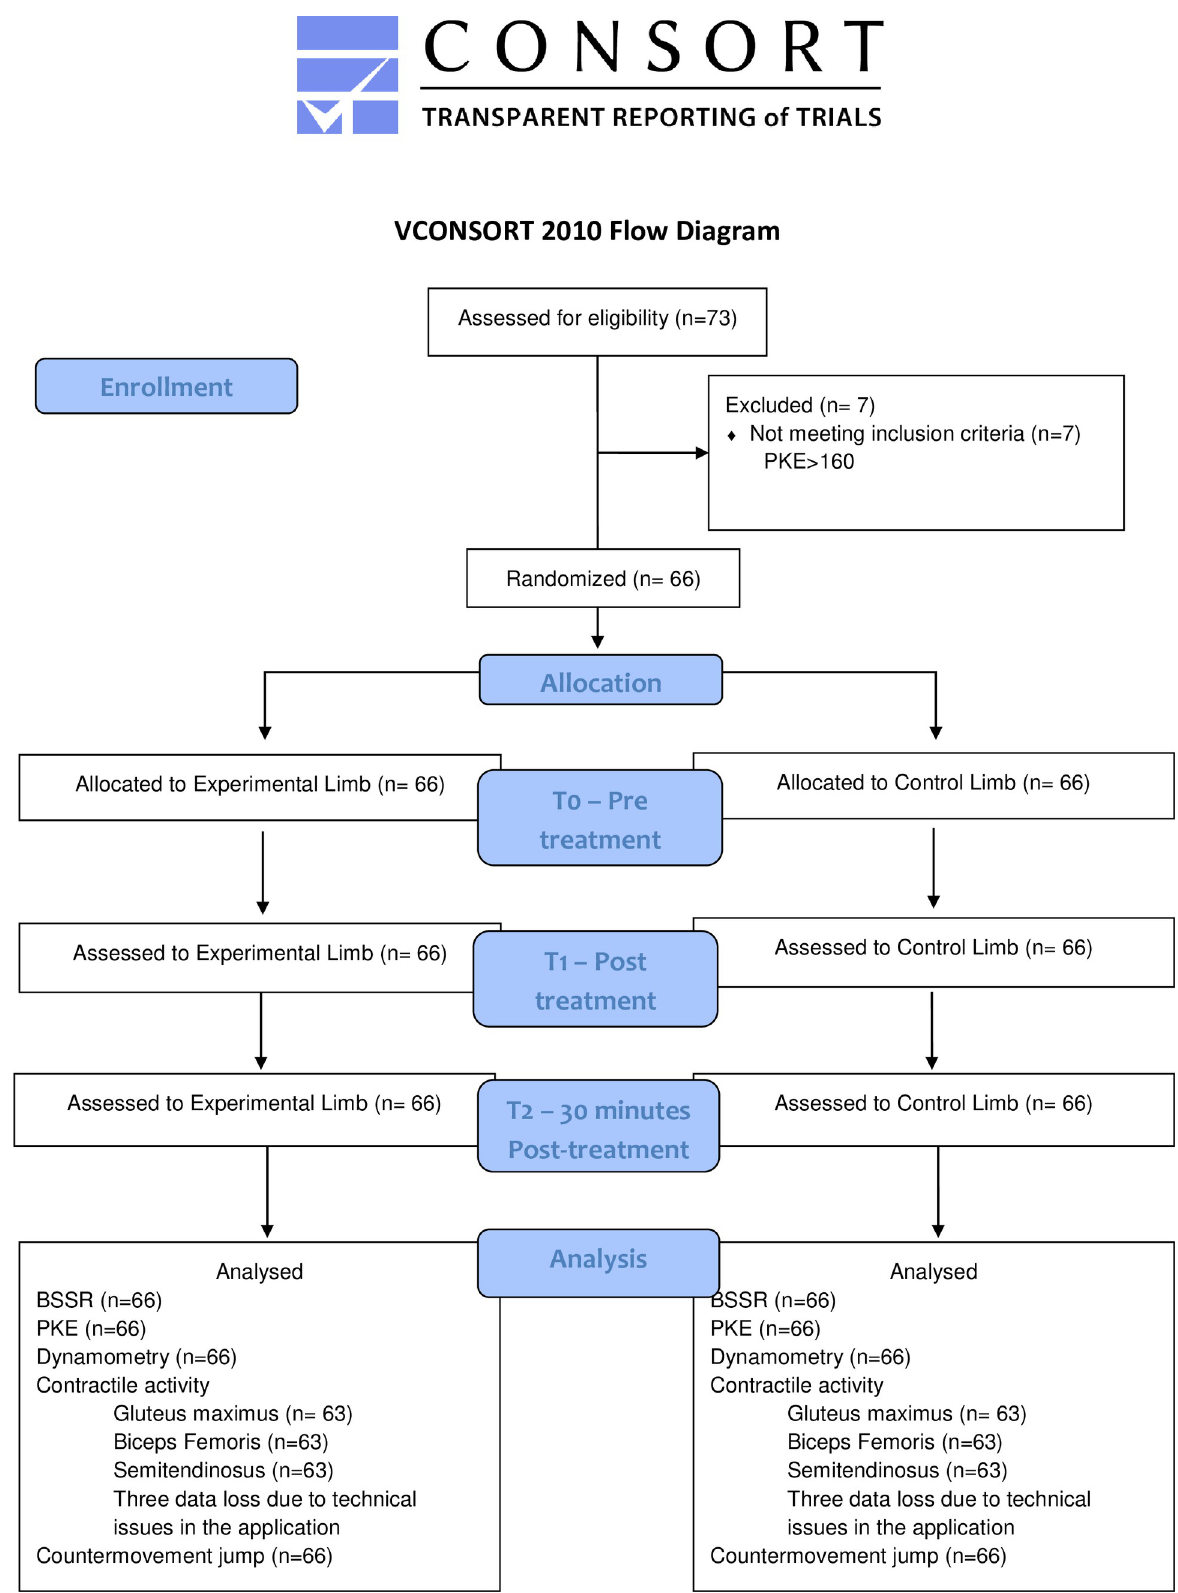
Fig 1. CONSORT flow diagram.